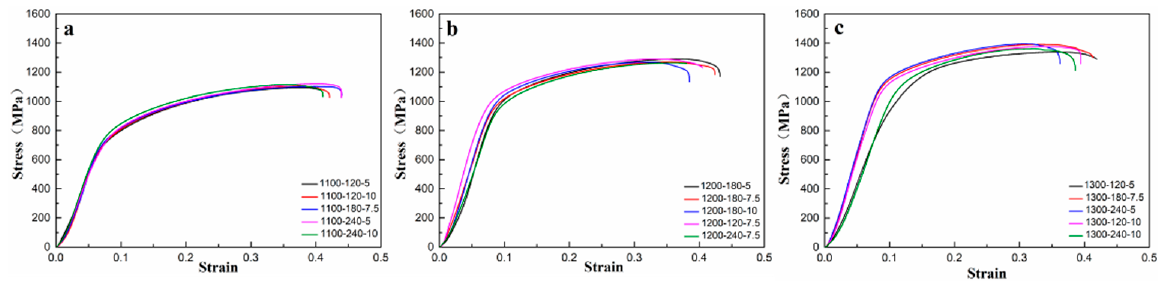
Figure 7. The compression curves of these samples when sintered at ( a ) 1300 °C, ( b ) 1200 °C and ( c ) 1100 °C.